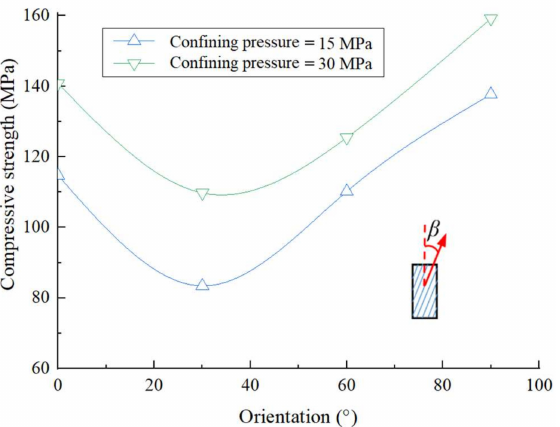
Figure 4. Changes in compressive strength (deviatoric stress) of dry shale with various axial direction—lamina angles ( β ).